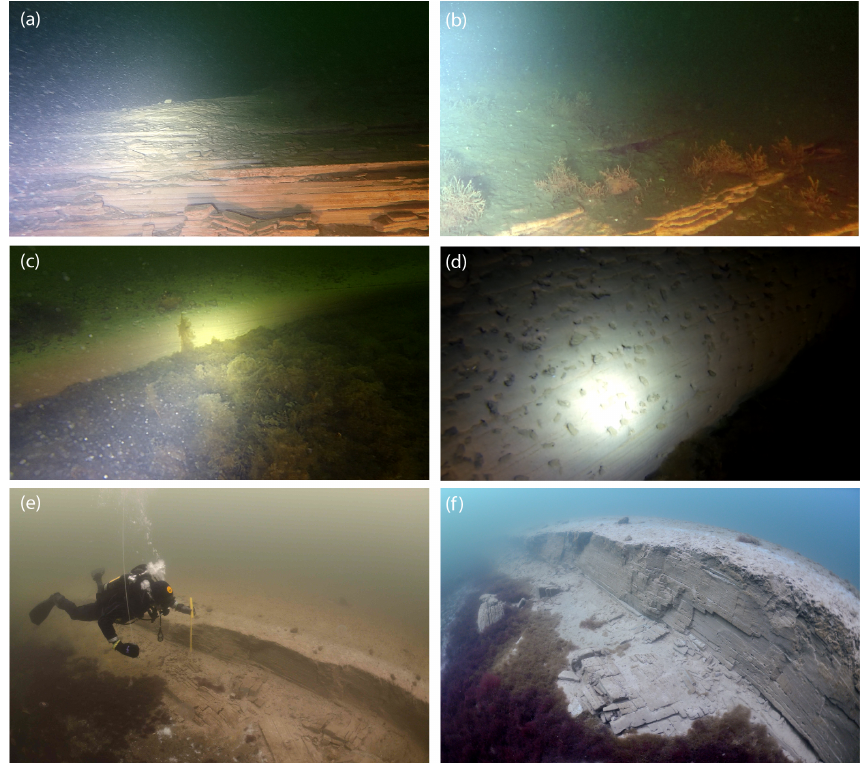
Figure 6. Bottom photographs of sea floor terraces in the studied areas. (a, b) East of the island of Askö, (c, d) east of Tvärminne Zoological Station in the southern Finland archipelago, (e, f) near Boön, Blekinge archipelago.